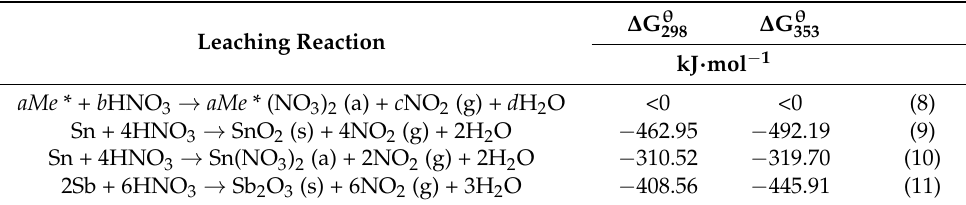
Table 3. ∆ G θ possible chemical reactions of metals with HNO 3 .